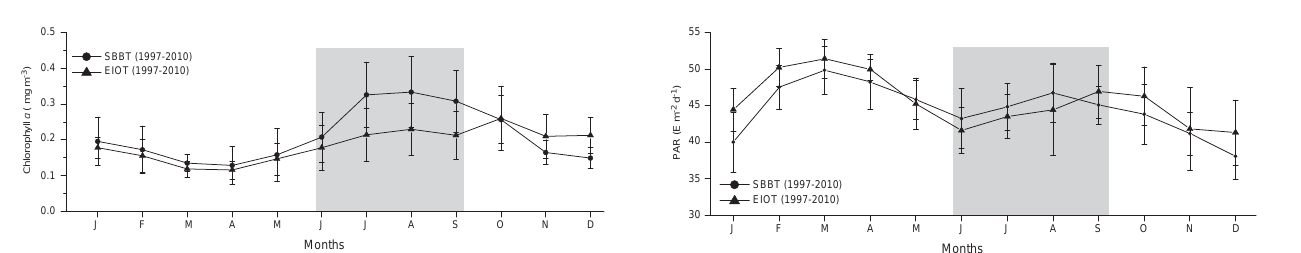
Fig. 5. Monthly mean climatology (1997–2010) of photosyntheti- cally active radiation (PAR) at SBBT (filled circle) and EIOT (filled triangle). Shading represents the summer monsoon period (June– September) and vertical lines are one standard